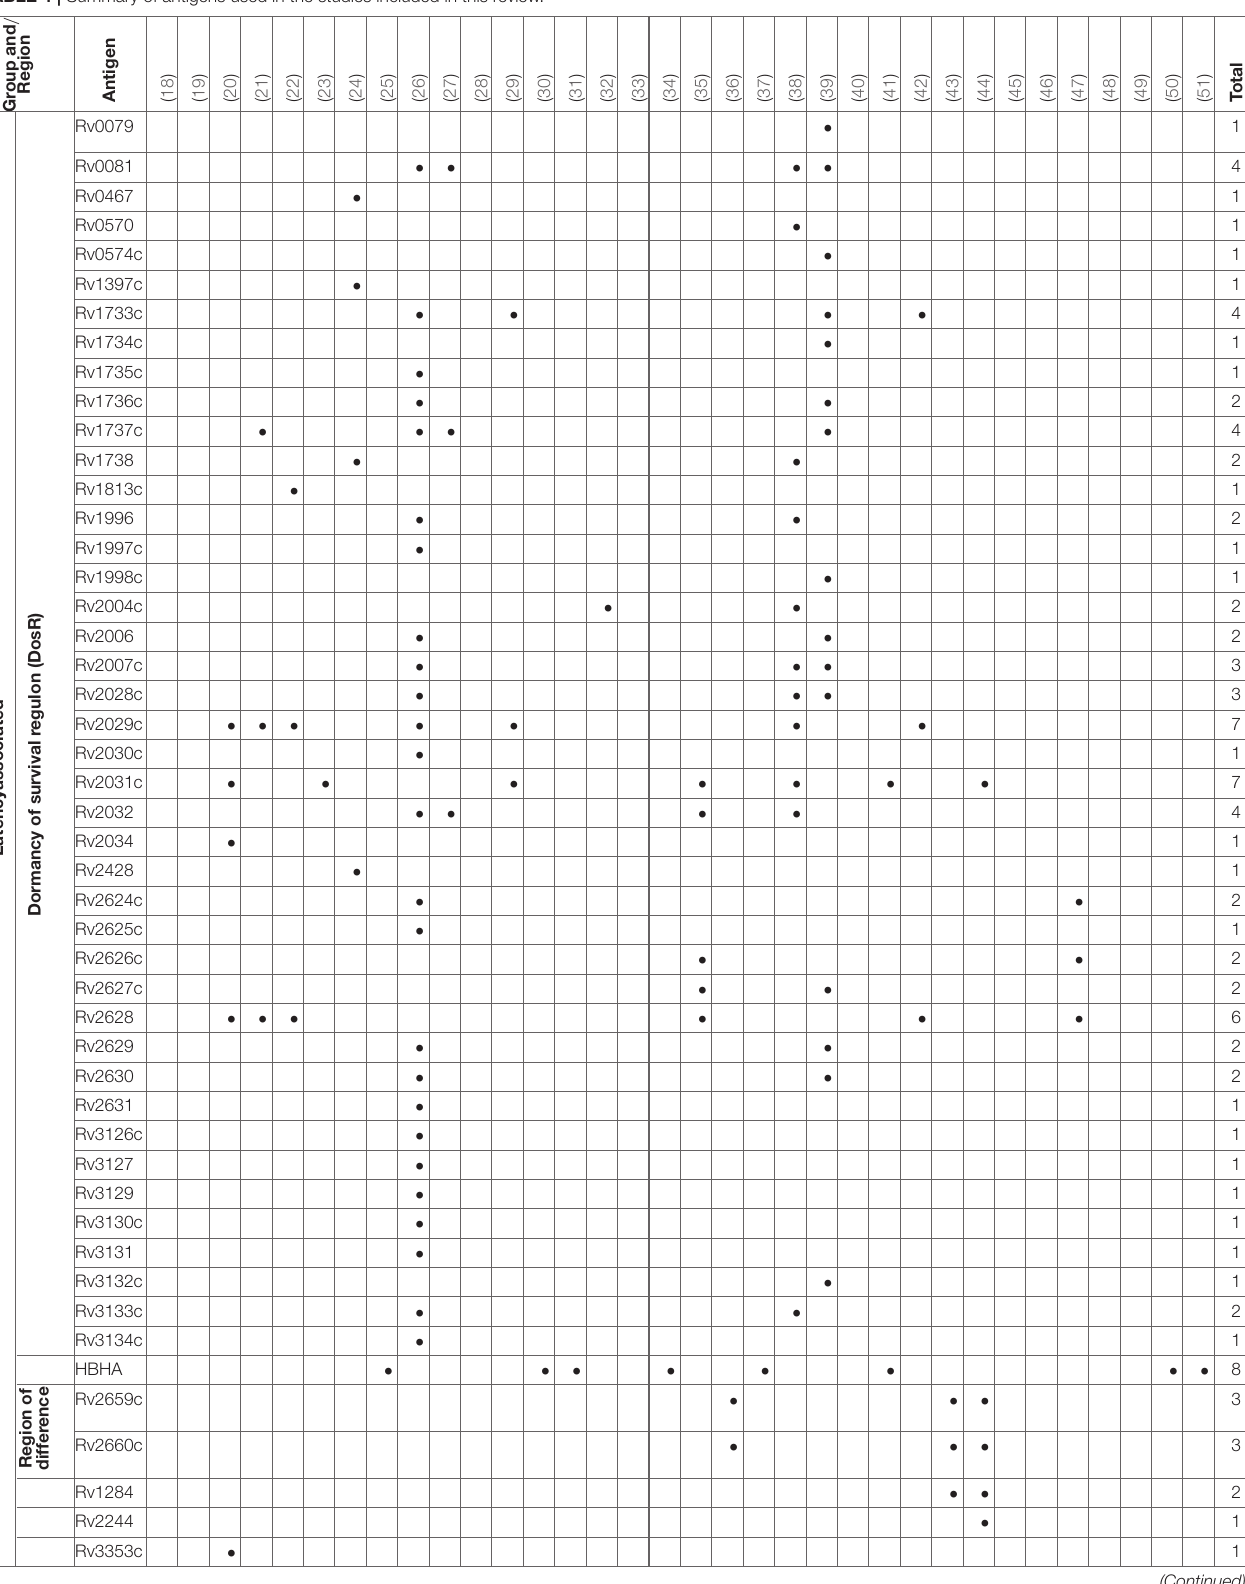
TABLE 4 | Summary of antigens used in the studies included in this